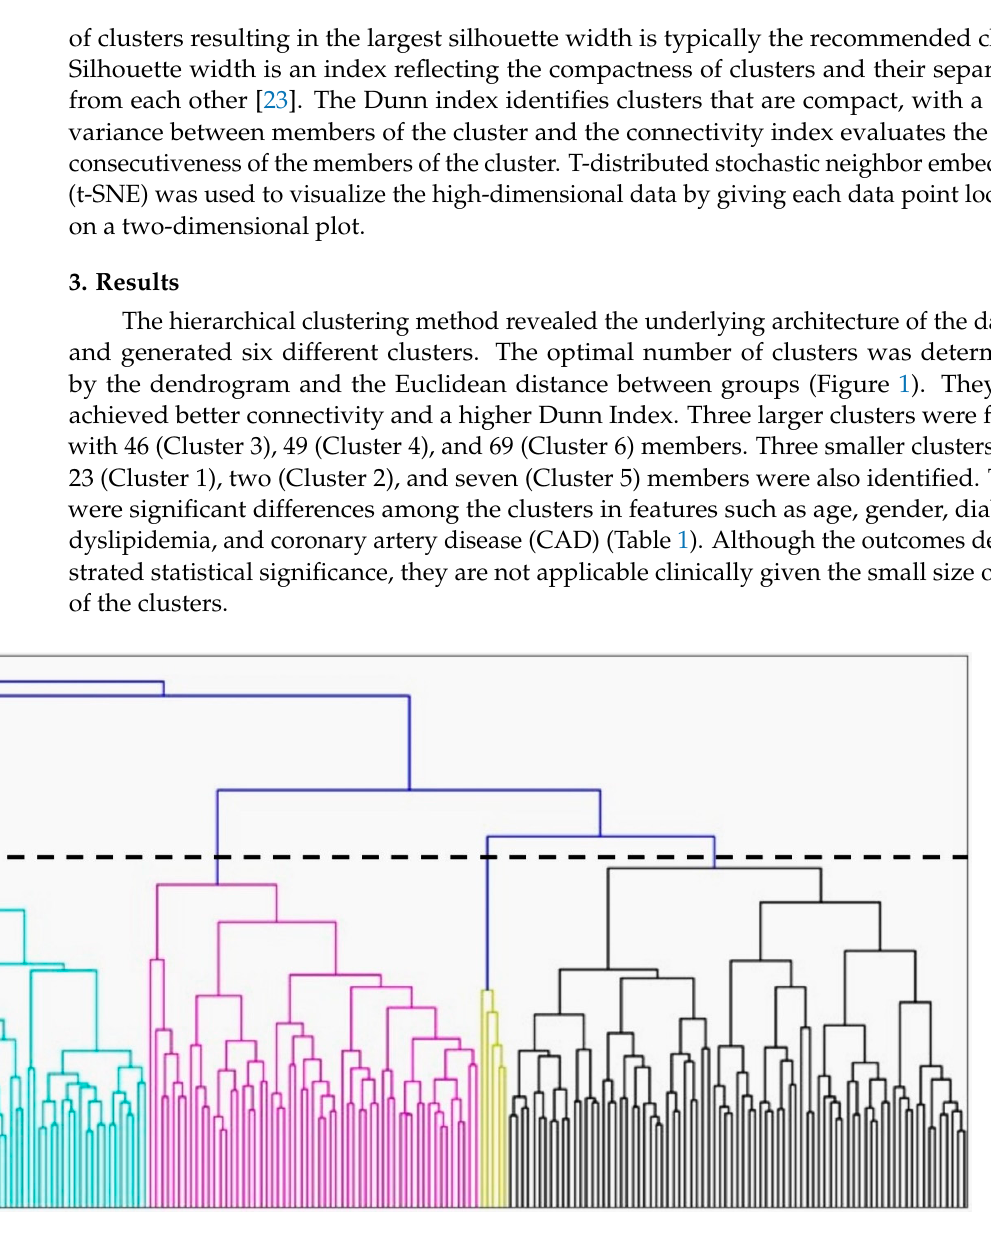
Figure 1. Dendrogram for hierarchical clustering ( n = 196). Each color represents once cluster (cluster 1: green, cluster 2: red, cluster 3: blue, cluster 4: pink, cluster 5: yellow, cluster 6: Table 1. Summary of clusters using the hierarchical method ( n = 196).